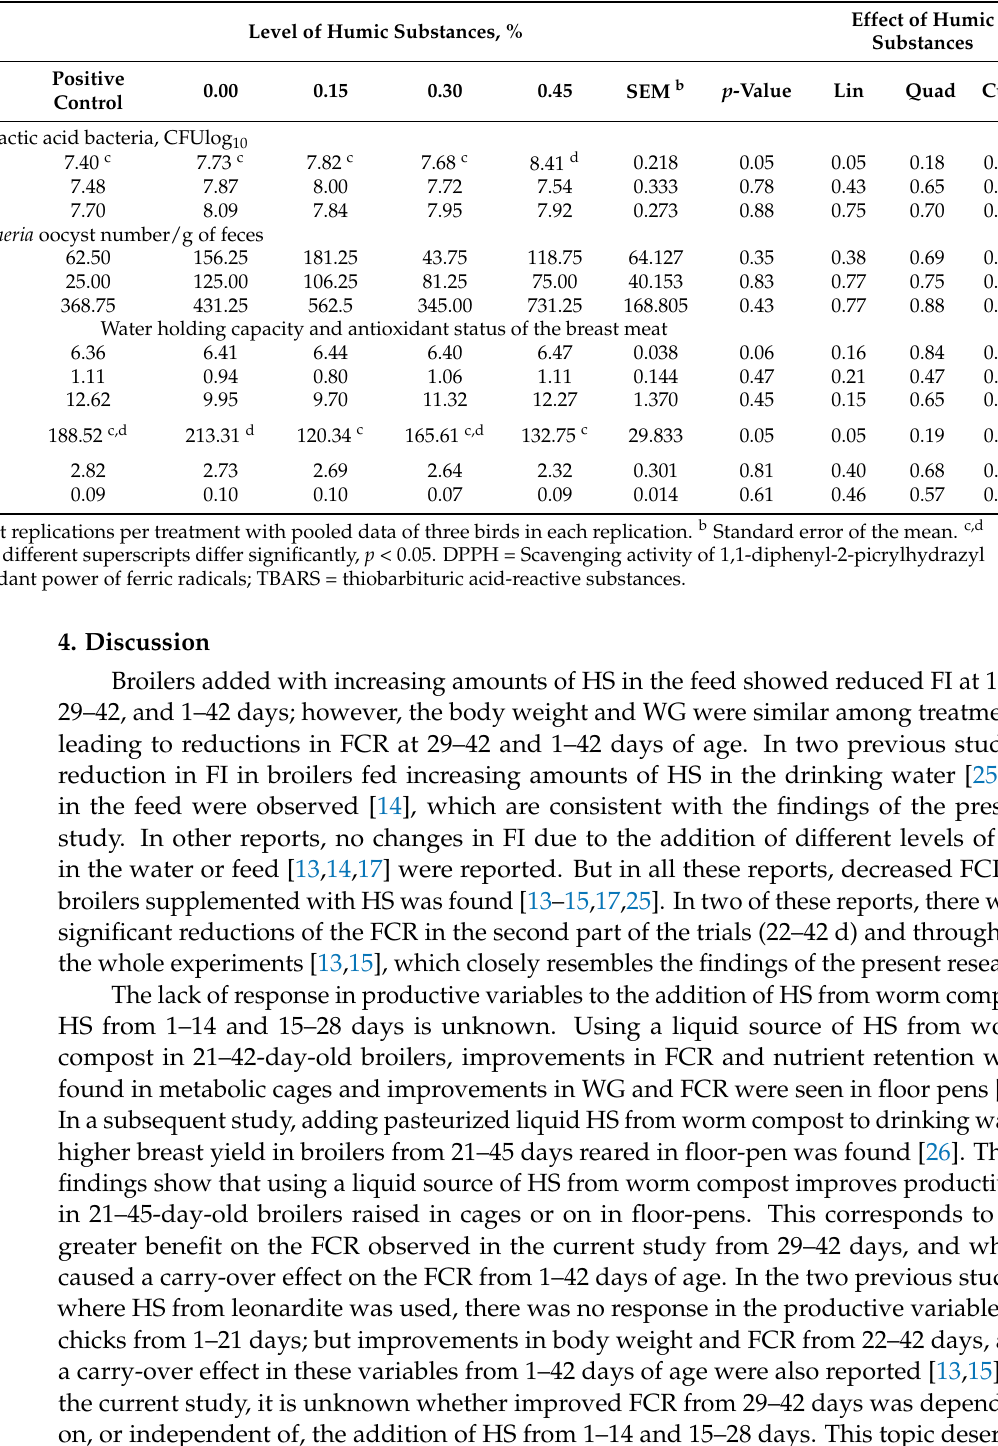
Table 5. Lactic acid bacteria count, Eimeria oocyst excretion and antioxidant status of the breast meat of broilers added with increasing levels of humic substances in the feed, probability level, and type of effect associated with humic substances.